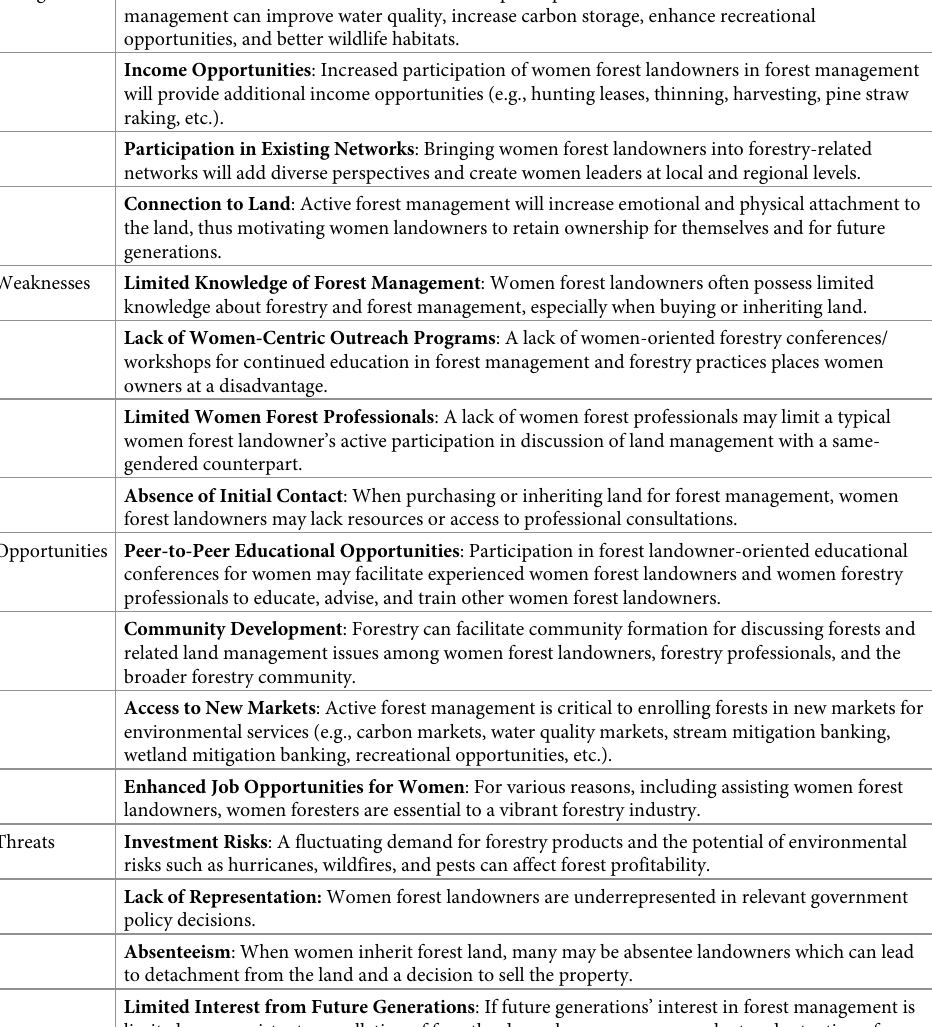
Table 2. SWOT factors and their definitions used in the first survey.